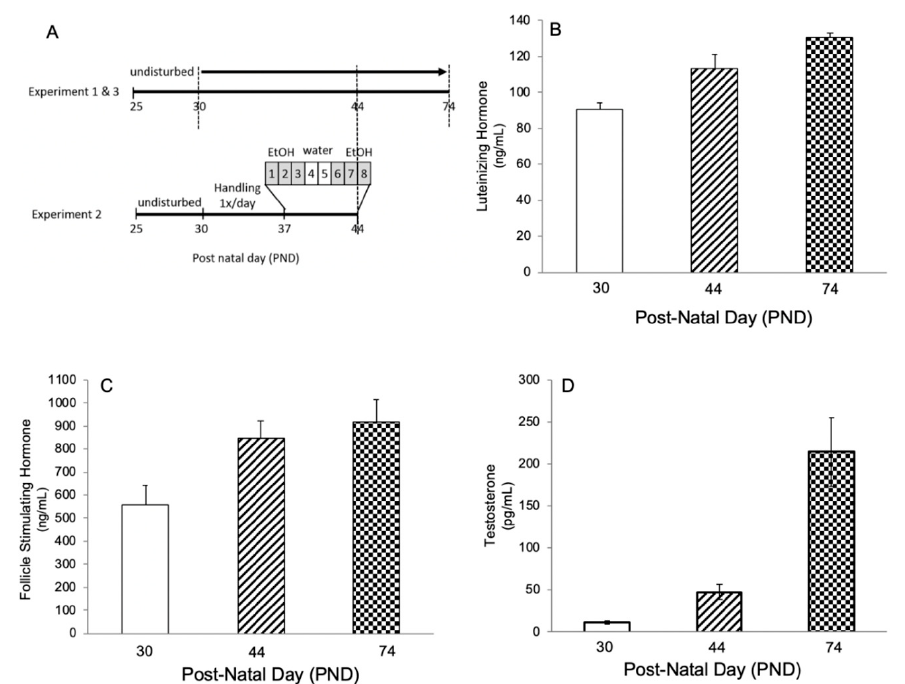
Figure 1. Animal paradigm and hormone levels across pubertal development. ( A ) Animal paradigm for Experiment 1 (untreated) and Experiment 2 (repeated binge ethanol exposure). Dotted lines indicate day of euthanasia. Plasma hormone levels of ( B ) luteinizing hormone (LH), ( C ) follicle-stimulating hormone (FSH), and ( D ) testosterone (T) in pre-, peri- and post-pubertal male rats (post-natal day (PND) 30, 44, and 74, respectively). Data are depicted as mean ± SEM, N = 10/age group. We also measured morphological markers of spermatogenesis in the testes of these males to assess the progression of sexual maturation. Spermatogonia and primary spermatocytes were visible in testes taken from PND 30 animals; however, as expected, a defined lumen and spermatids were